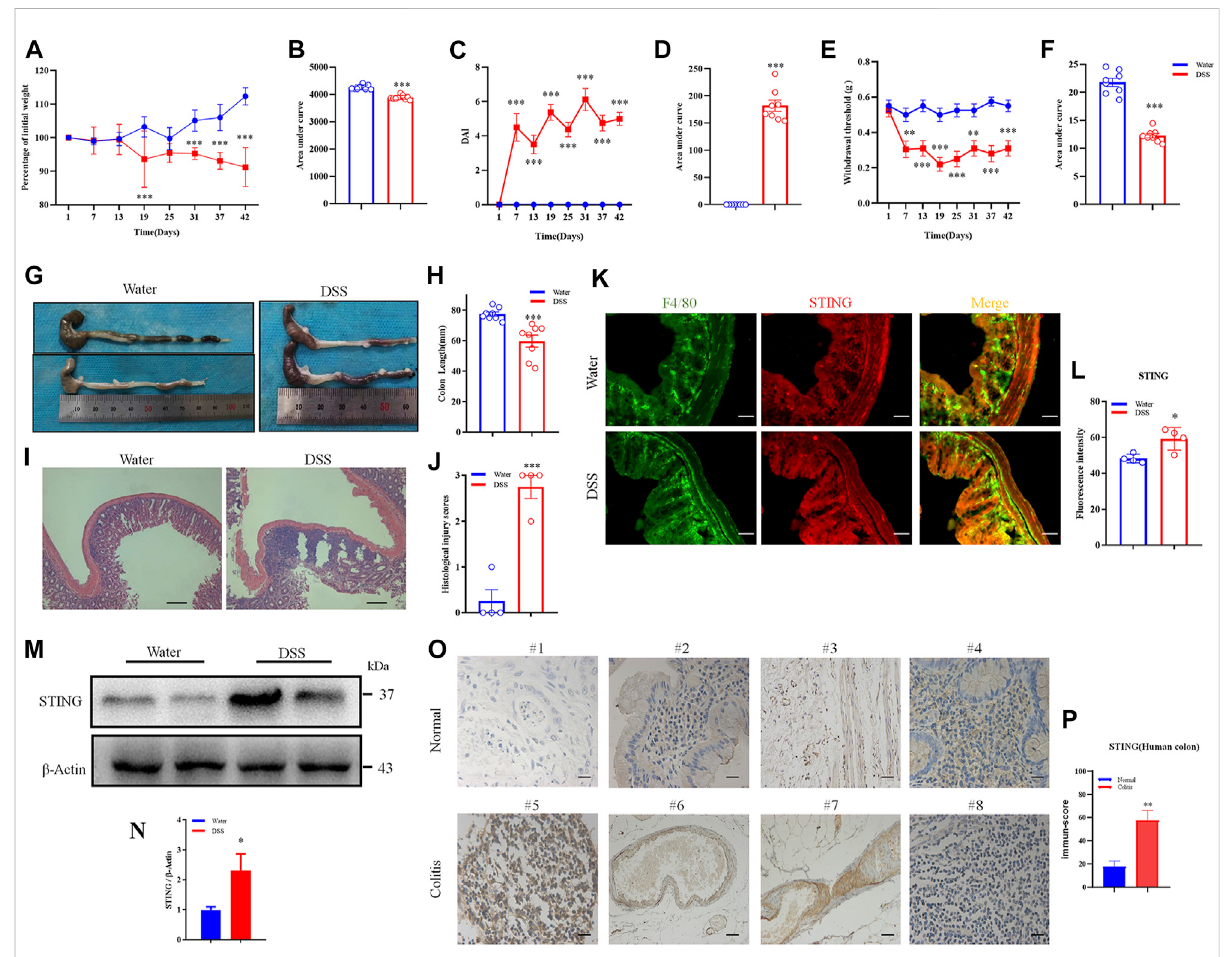
FIGURE 3 STING was upregulated following DSS-induced chronic colitis in mice and in UC patients. (A) Body weight loss was induced by DSS-colitis in mice. (B) The quanti fi cation of area under the curve (AUC) for (A) . (C) DSS-colitis induced changes of the Disease activity index (DAI) score. (D) The quanti fi cation of AUC for (C) . (E) DSS-colitis induced mechanical pain hypersensitivity in the abdomen. (F) The quanti fi cation of AUC for (E) . (n = 7- 8 per group; * p < 0.05, ** p < 0.05, *** p < 0.001, DSS vs. vehicle group; two-way ANOVA with post-hoc Bonferroni test). (G) Representative pictures showed colon shortening induced by DSS. (H) The quanti fi cation of colon shortening for (G) . (n = 7-8 per group; *** p < 0.001, DSS vs. vehicle group; unpaired Student ’ s t-test). (I) Representative H&E staining of colon sections from DSS group and vehicle group. (J) Statistical analysis for (I) .( n =4eachgroup,*** p < 0.001,DSSvs.vehiclegroup;unpairedStudent ’ st-test). (K) DoubleimmunostainingofSTINGandF4/80inthecolon tissuefromDSSgroupandvehiclegroup. (L) Statisticalanalysisfor (K) ,scalebar:50 μ m.( n =4eachgroup,* p <